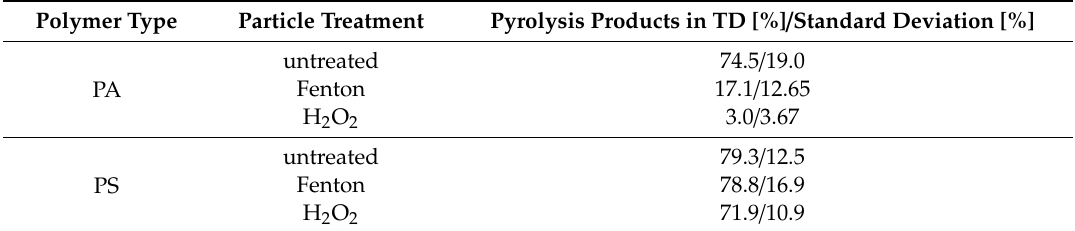
Table 5. Influence on the partial pyrolysis of thermal desorption (TD) products at 200 ◦ C for both PA and